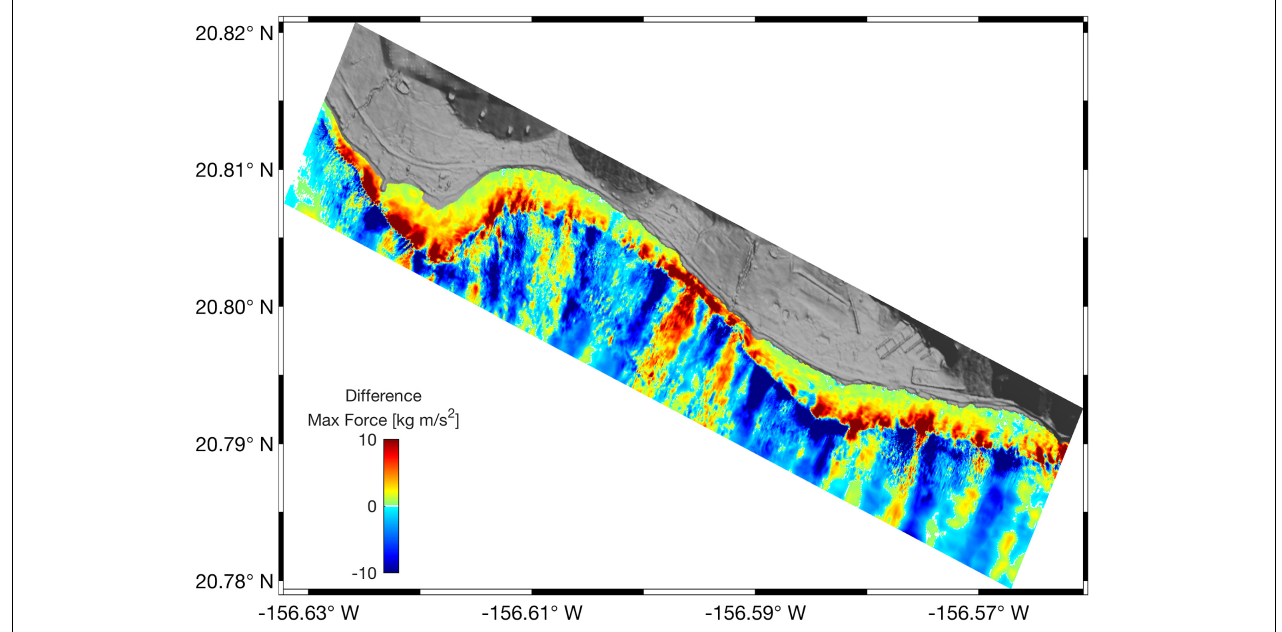
FIGURE 1 | The difference in maximum hydrodynamic force per unit shoreline width from the BOSZ model for a wave event at Olowalu, Ukumehame, West Maui (high tide minus low tide). The tidal levels where set at MSL + 0.6 m for high tide and MSL – 0.3 m for low tide. The wave input conditions are identical in both scenarios, arriving from due south with H s = 1.5 m, T p = 14 s, and a typical directional spreading of 30 ◦